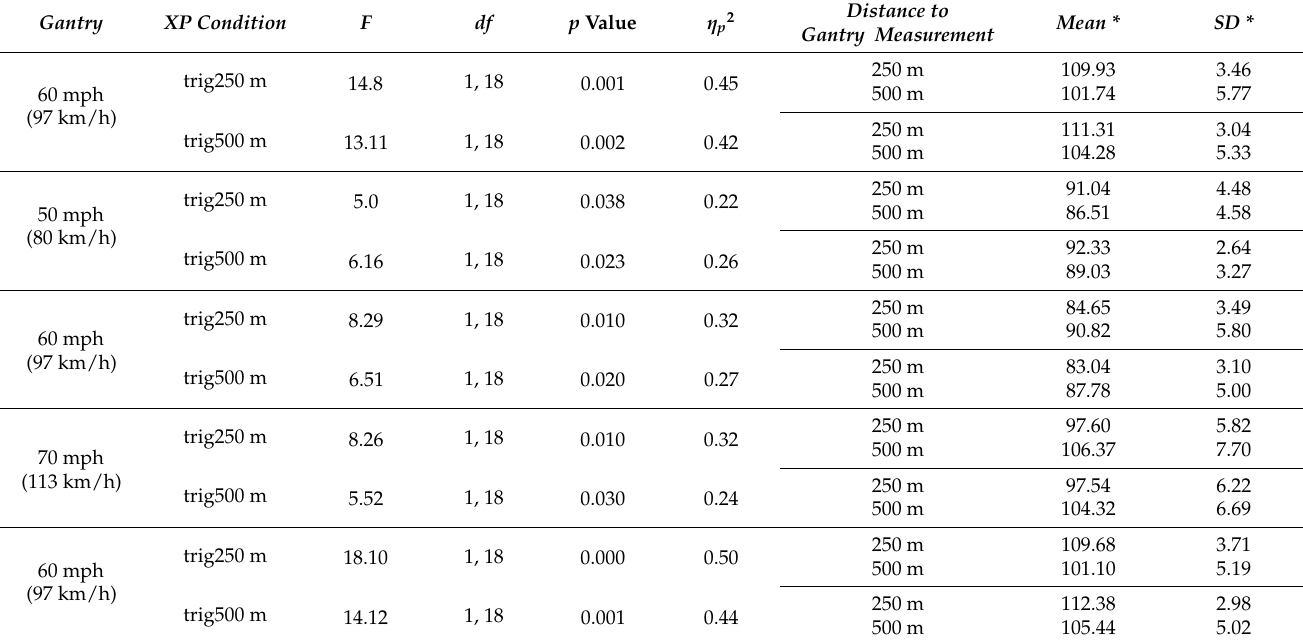
Table 5. Analysis of variance to test the effect of the HMI trigger on mean speed values. Scores reported in